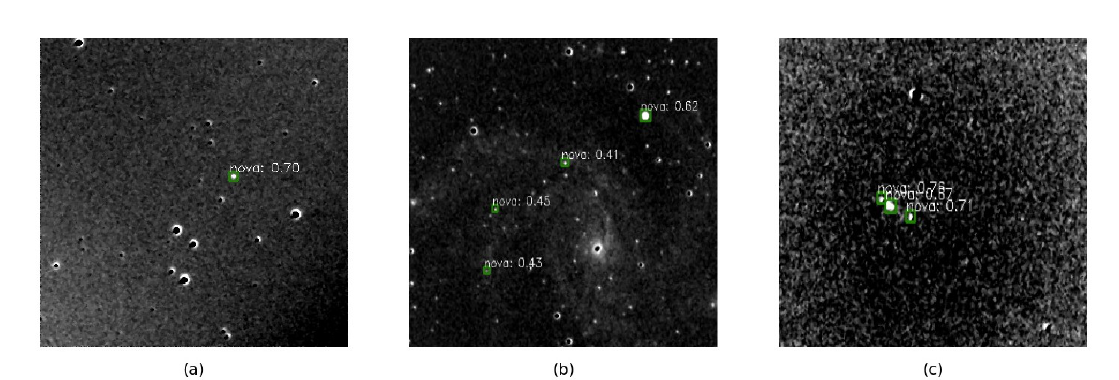
Figure 7. The unaligned images cause false positive predictions. Green box indicates the location of the supernova. The classification result and confidence is labeled above the green box. ( a ) The model doesn’t mistake unaligned stars as supernovae. The model can discover the features of unaligned stars to some extent. ( b ) Unaligned stars are mistaken for supernovae. ( c ) Unaligned edges of galaxies are mistaken for supernovae.